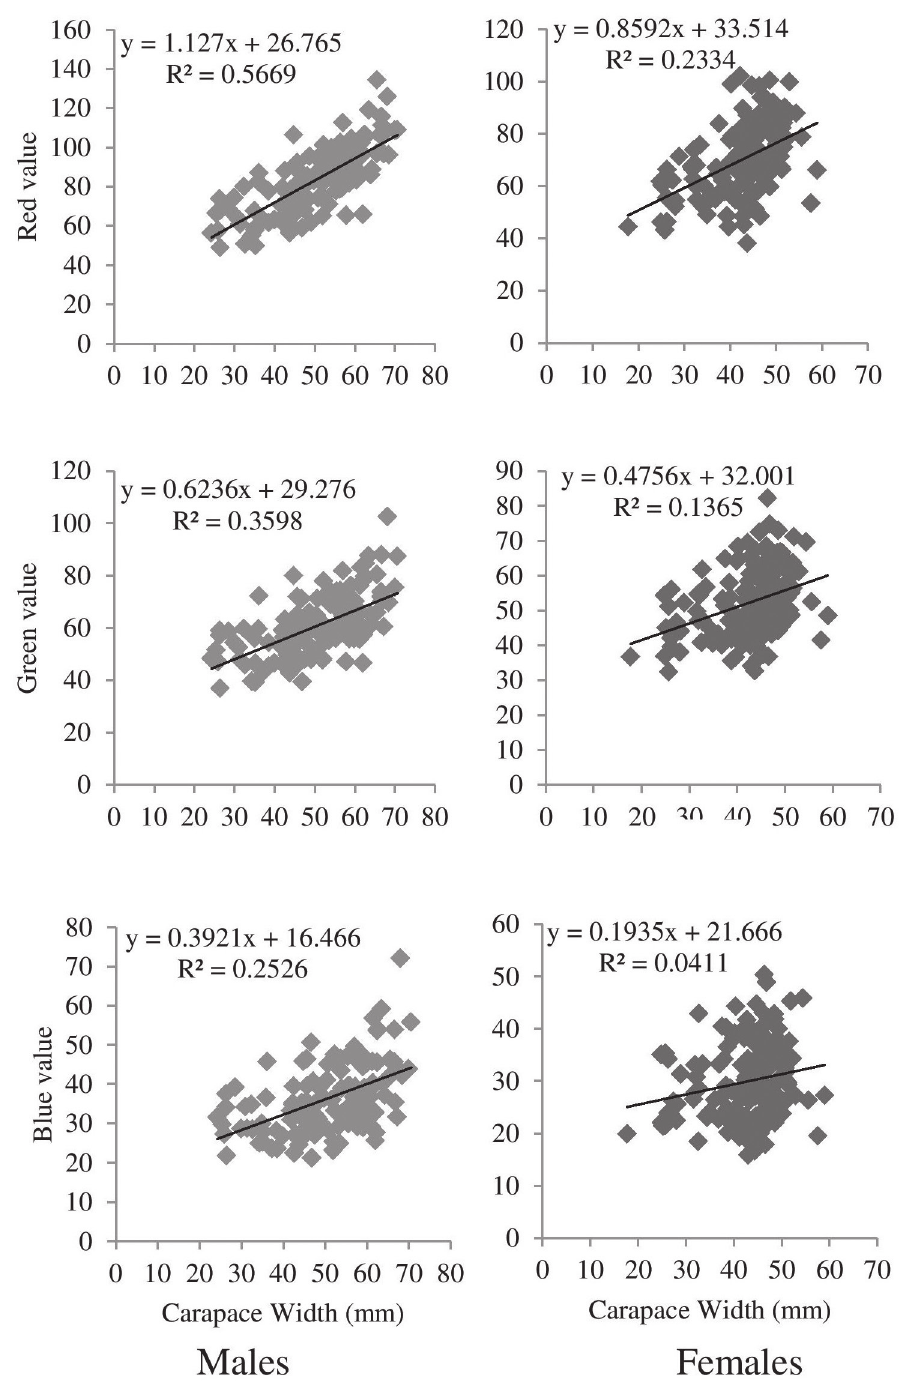
Figure 5 - Relationship between cheliped (external) colors and size for both males and females of Charybdis hellerii (, DF=1, P< 0.0001; F =159.6649, DF=1, P <0.0001; F =45.3566, DF=1, red(m) red(f) P <0.0001; F =68.5695, DF=1, P <0.0001; F =23.5528, DF=1, P <0.0001; F =41.2313, green(m) green(f) blue(m) DF=1, P <0.0001; F =6.3794, DF=1, P =0.0121). Alpha value after Bonferroni correction P= blue(f)